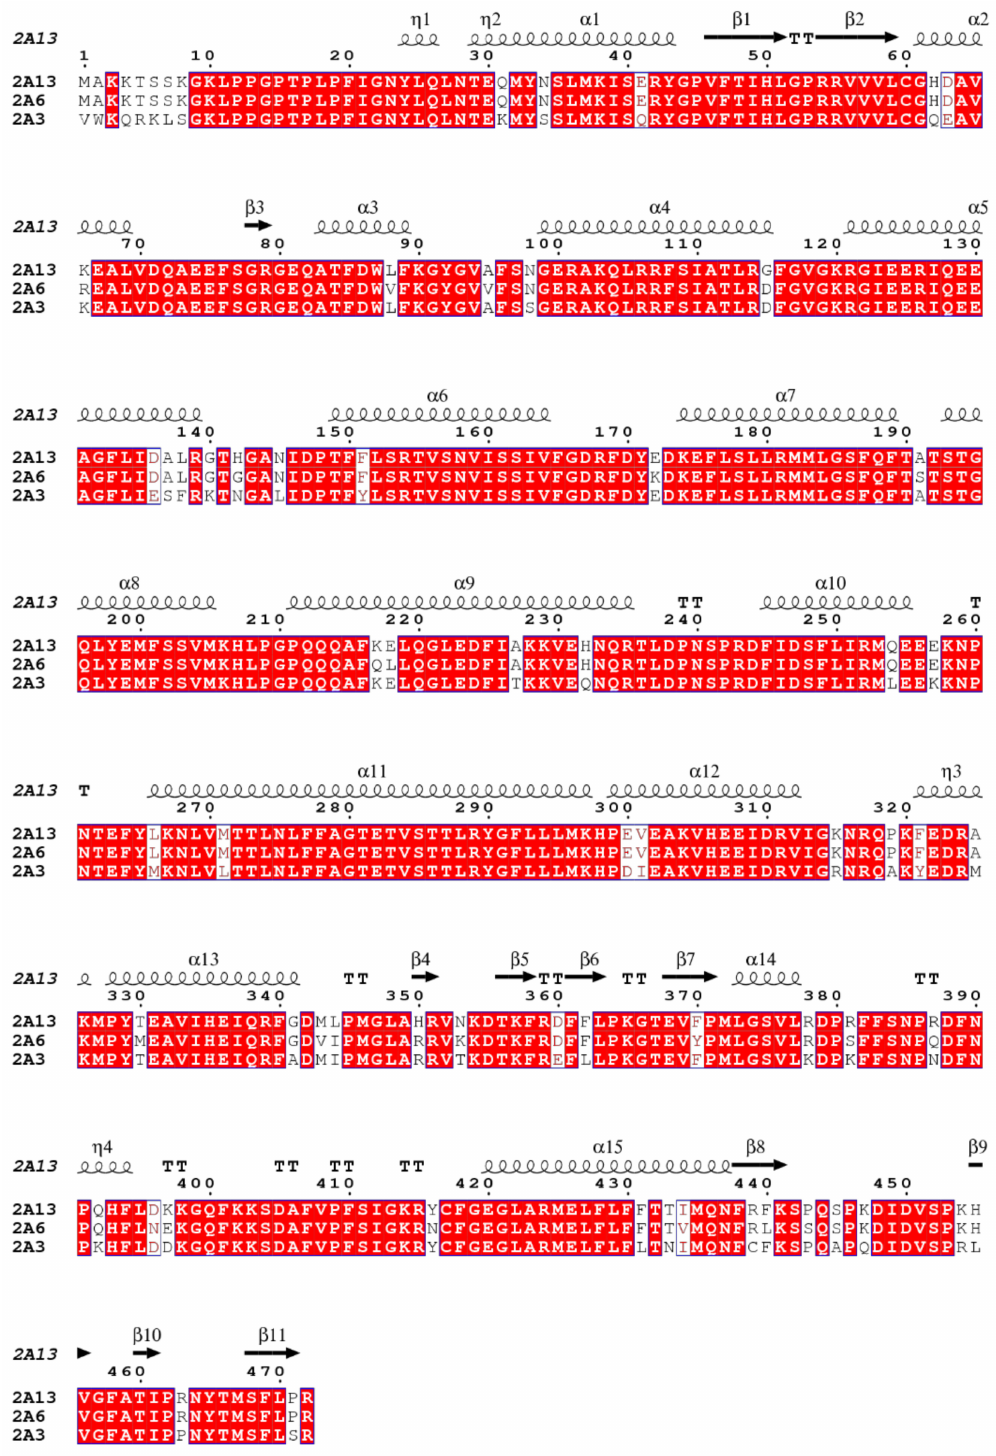
Figure 6. Sequence alignment of human 2A6, 2A13 and rat